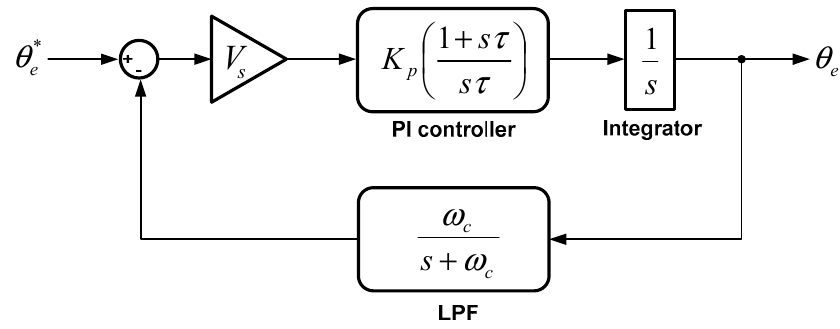
Figure 7. Block diagram of a single-phase synchronous reference frame-phase locked loop (SRF-PLL) controller.